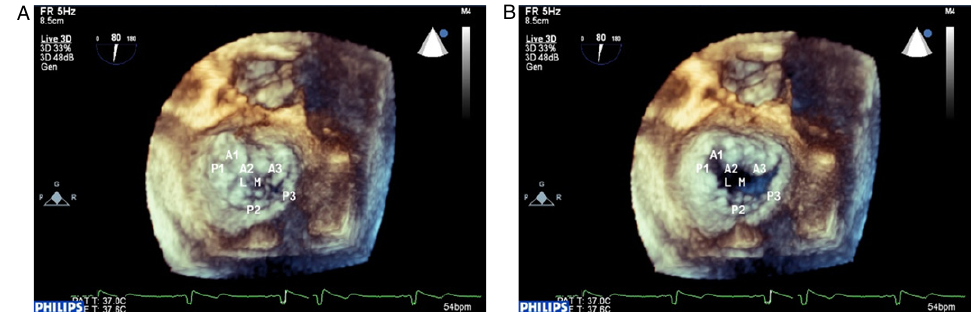
Figure. 1 The mitral valve as visualized from the left atrial perspective in closed position (A) and open position (B). The anterior and posterior leaflets are labeled as A1, A2, A3; and P1 (lateral scallop), P2 (middle scallop) and